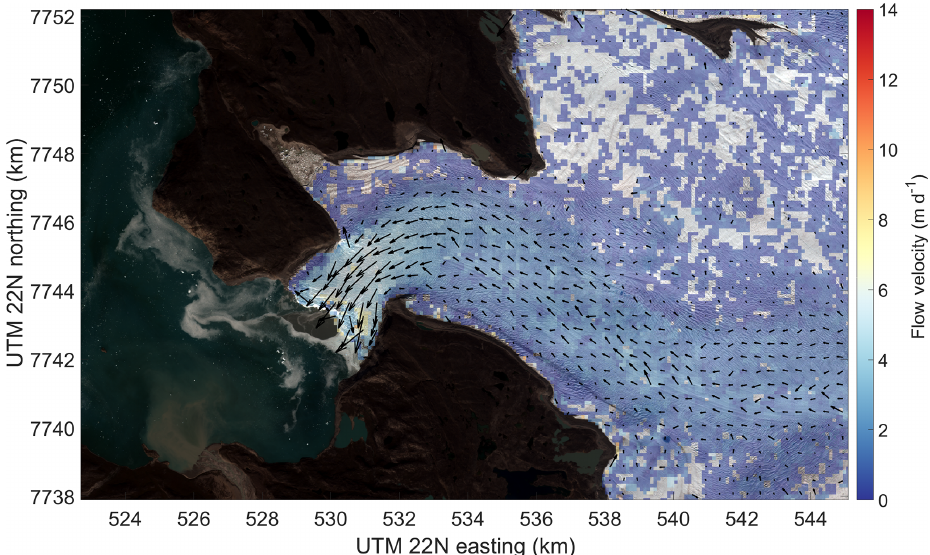
Figure 4. Flow velocity field (magnitude and direction) from intensity tracking based on subsequent Sentinel-1A acquisitions with a time difference of 12d (13–25 August 2016). Note that the low values close to the calving margin are due to image templates containing mixed information from the glacier and the sea, leading to erroneous values. Transparent areas on the glacier depict pixels flagged as outliers. Background: Sentinel-2A scene from 3 August 2016. This figure contains Copernicus Sentinel data (2016).